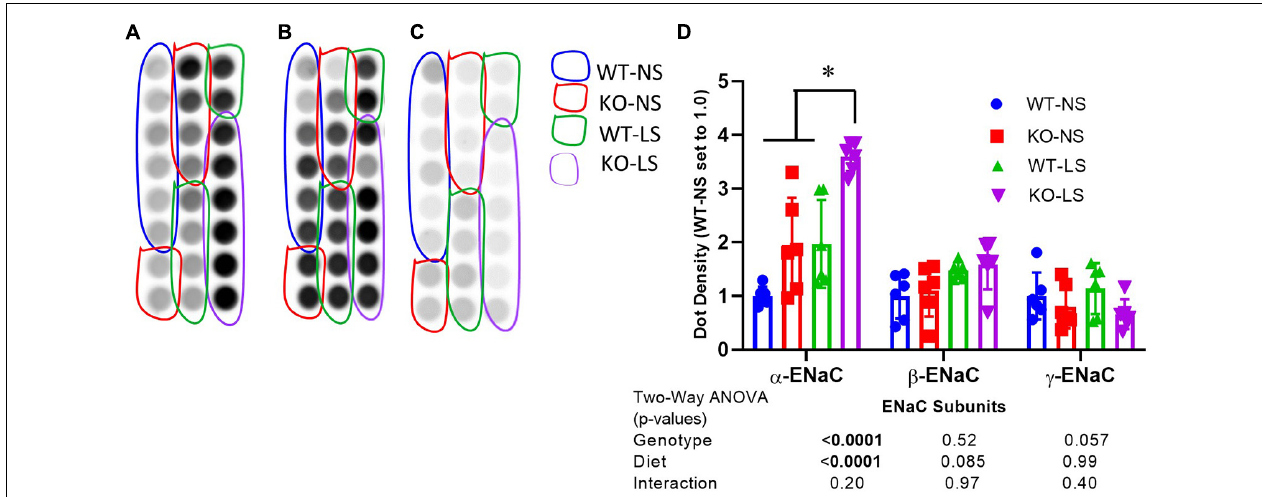
FIGURE 6 | Ubiquitination of α -ENaC increased in KO kidney. Ubiquitination of (A) α -, (B) β -, and (C) γ -ENaC in kidney cortex homogenates of LS and NS-treated male and female mice was assessed by an ELISA-based approach first immunoprecipitating all ubiquitinated proteins and then probing with anti-ENaC subunit antibodies. (D) Density summary of dots (mean ± sem) normalized to WT-NS ( n = 6/genotype/sex/treatment). α -ENaC showed increased ubiquitination in the KO and reduced ubiquitination with LS diet. *indicates a significant difference ( p < 0.05) by multiple comparisons testing following a significant 2-way